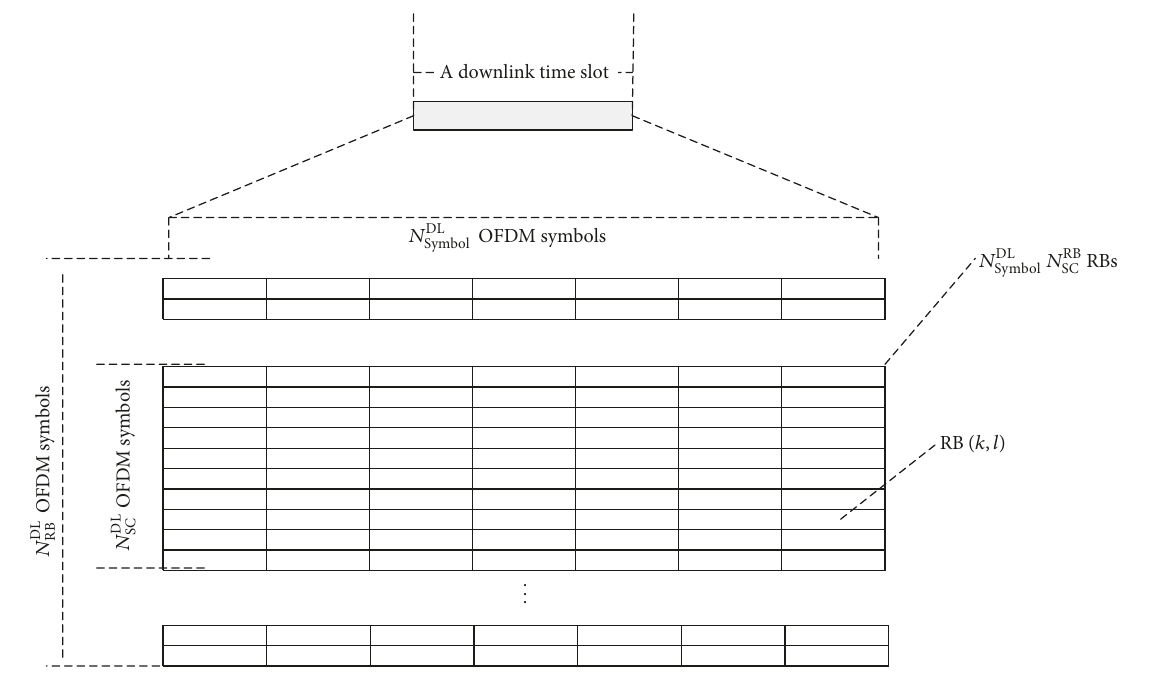
Figure 2: Schematic of RB in